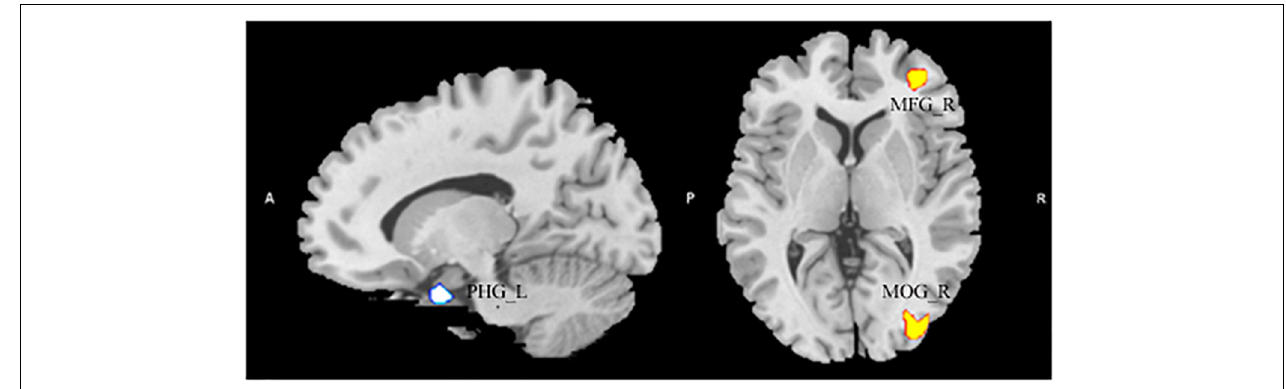
FIGURE 1 | The significant positive correlation between gray matter volume (GMV) and Autism Spectrum Quotient score showing areas in the right middle frontal gyrus and in the middle occipital gyrus, and had a significant negative association with the GMV in the left parahippocampal gyrus. Alphasim-corrected cluster level p < 0.05, voxel-wise level p <